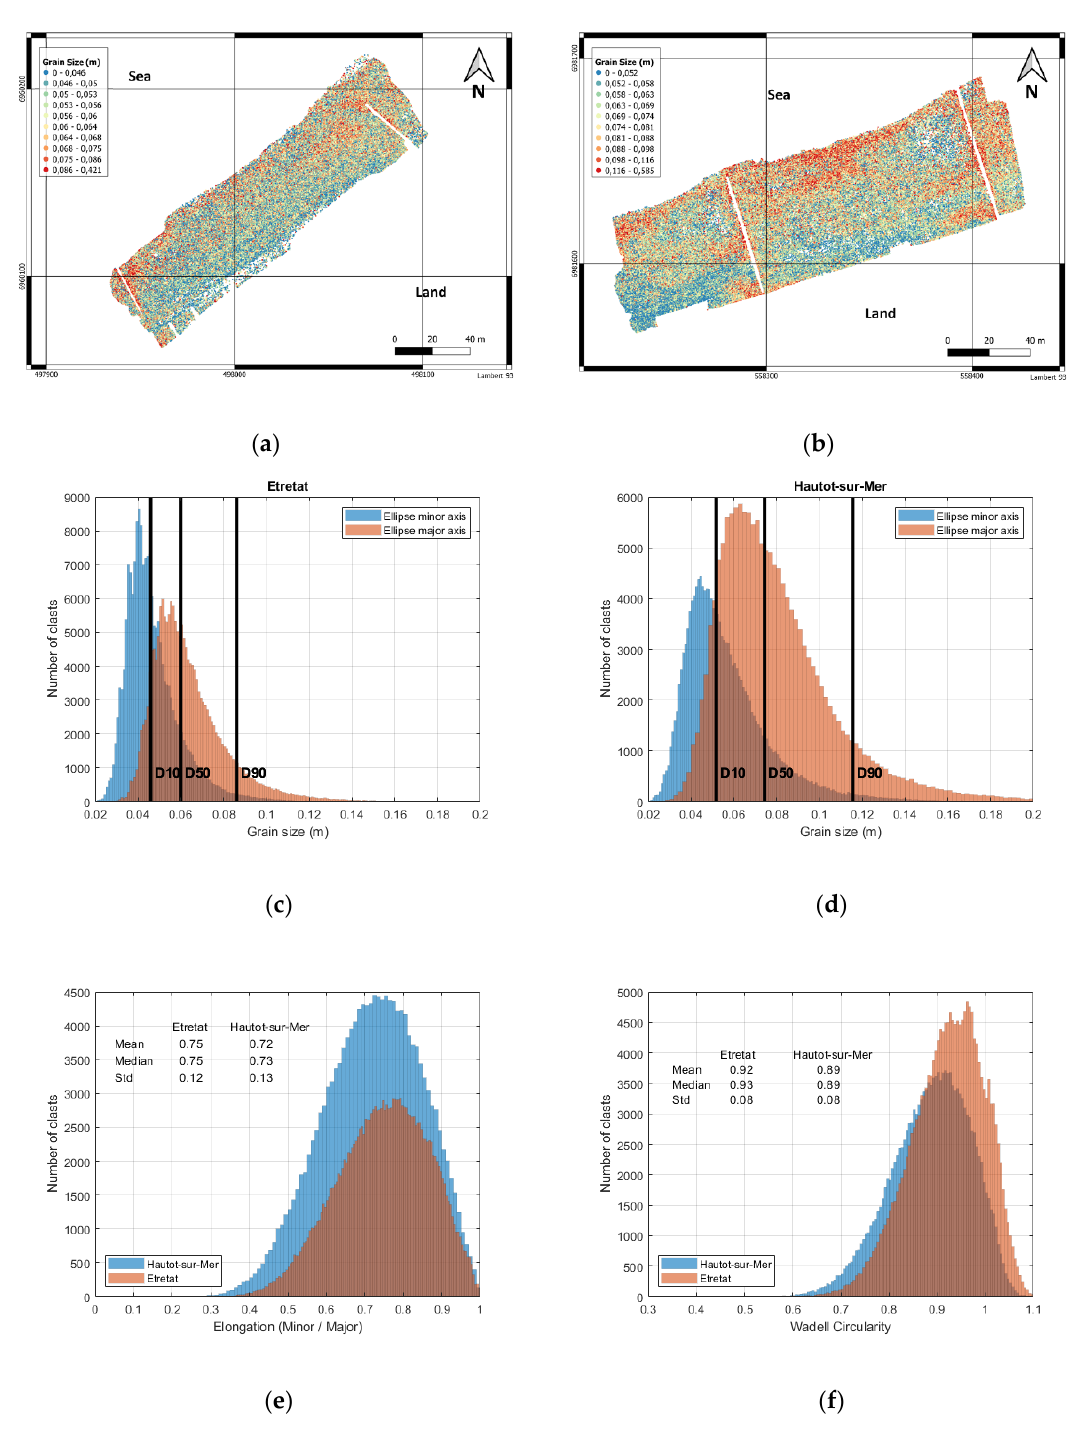
Figure 12. Distribution of individual pebbles on the surface of the beaches of ( a ) Etretat and ( b ) Hautot-sur-Mer. Histograms of the grain size distribution at ( c ) Etretat and ( d ) Hautot-sur-Mer, orange bars show the ellipse major axis dimensions, blue bars refer to the minor axis, and black vertical lines locate the major axis distribution’s D10, D50 and D90 values. Histogram of the grain elongation values ( e ) and of the grain circularity values ( f ) Etretat (orange) and Hautot-sur-Mer (blue).